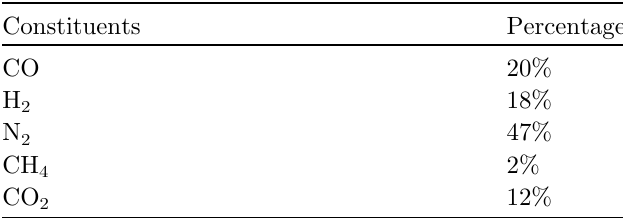
Table 1. Typical composition of the producer gas.